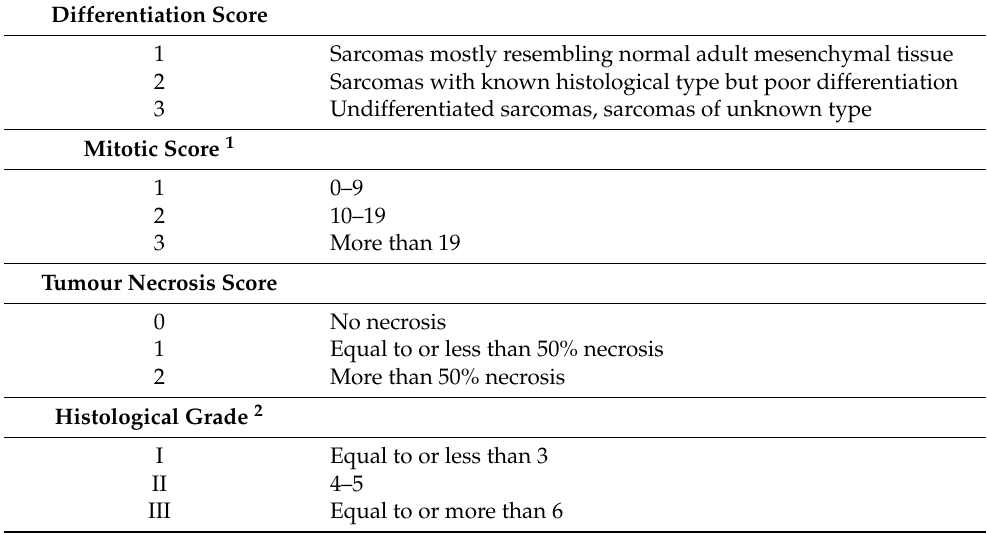
Table 1. Human soft tissue sarcoma grading system [32] as also routinely replied to canine soft tissue